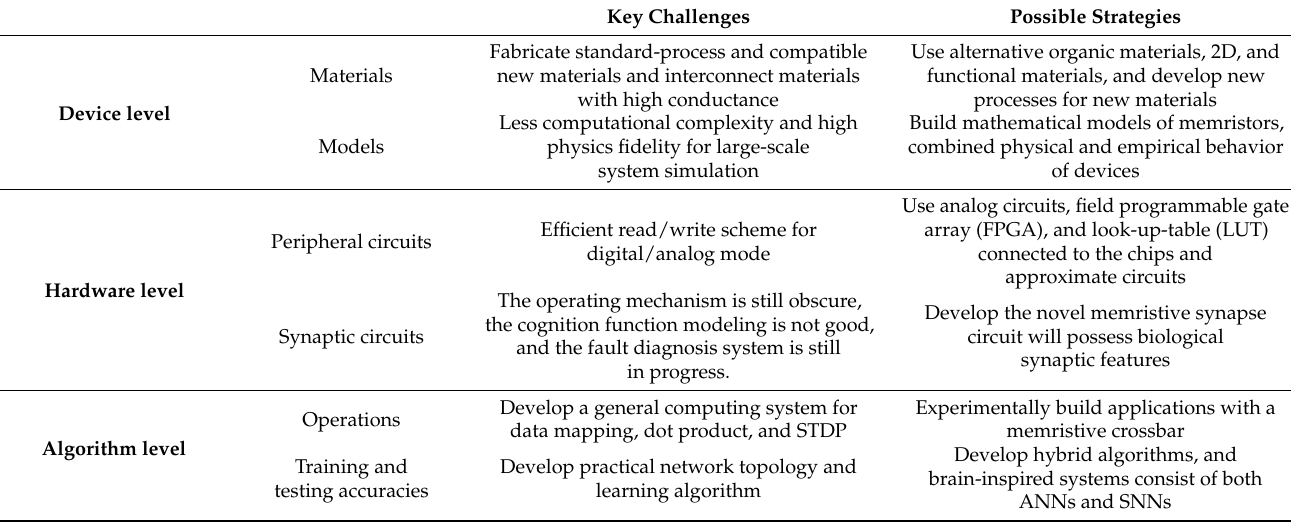
Table 5. Key challenges and possible strategies of memristive system-based image processing technology on the device, hardware, and algorithm